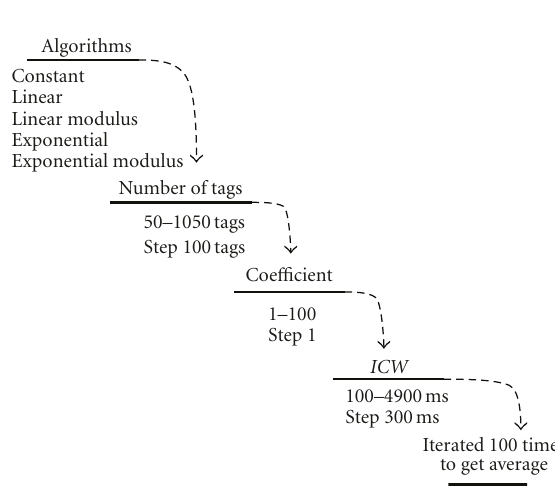
Figure 7: The simulation